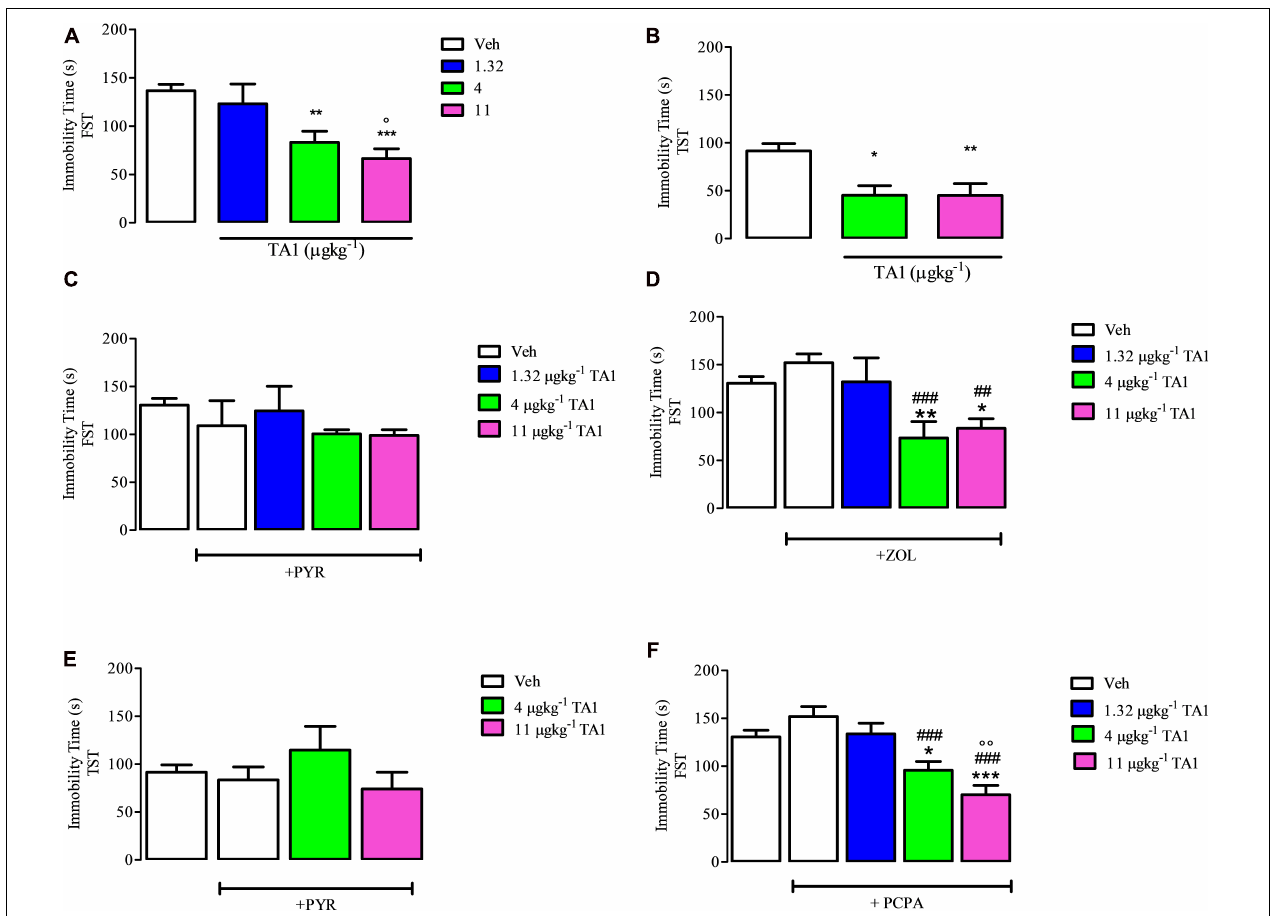
FIGURE 4 | The effect of 3-iodothyroacetic acid (TA1) treatment on the immobility time in the forced swim test (FST) and in the tail suspension test (TST): evidence for the involvement of histamine and not of serotonin. Mice received 1.32, 4 and 11 µ gkg − 1 TA1 and after 15 min they were subjected to the FST (A) or to TST (B) . The immobility time was measured as described in Methods. (A) The immobility time measured in mice subjected to the FST is reported. Results are the means ± SEM of three different experiments were at least ten mice were used ( ∗∗ P < 0.01 and ∗∗∗ P < 0.001 vs. Veh and ◦ P < 0.05 vs. 1.32 µ gkg − 1 TA1; One-way ANOVA test followed by Tukey Multiple Comparison Test). (B) Immobility time measured in mice subjected to the TST is reported. Results are the means ± SEM of three different experiments using at least ten mice ( ∗ P < 0.05 and ∗∗ P < 0.01 vs. Veh; One-way ANOVA test followed by Tukey Multiple Comparison Test). (C,D) The FST was then repeated in mice pre-treated with Vehicle (Veh) or with pyrilamine (10 mgkg − 1 ; PYR; C ) or with zolantidine (5 mgkg − 1 , ZOL; D ) before receiving 4 or 11 µ gkg − 1 TA1 as described in Methods. The Immobility time was measured. Results are the means ± SEM of three different experiments were at least ten mice were used ( ∗ P < 0.05 and ∗∗ P < 0.01 vs. Veh; ### P < 0.001 and ## P < 0.01 vs. ZOL, One-way ANOVA test followed by Tukey Multiple Comparison Test ); (E) The TST was repeated in mice pre-treated with pyrilamine (10 mgkg − 1 ; PYR) before receiving 4 and 11 µ gkg − 1 TA1 as described in Methods. The Immobility time was measured. Results are the means ± SEM of three different experiments were at least ten mice were used (One-way ANOVA test followed by Tukey Multiple Comparison Test); (F) the FST was repeated in mice pre-treated for 4 days with p-chloro methyltyrosine (100 mgkg − 1 ; PCPA) and then with 1.32, 4 and 11 µ gkg − 1 TA1 as described in Methods. The Immobility time was measured. Results are the means ± SEM of three different experiments were at least ten mice were used ( ∗ P < 0.05 and ∗∗∗ P < 0.001 vs. Veh, ### P < 0.001 vs. PCPA, ◦◦ P < 0.01 vs. 1.32 µ gkg − 1 ; One-way ANOVA test followed by Tukey Multiple Comparison